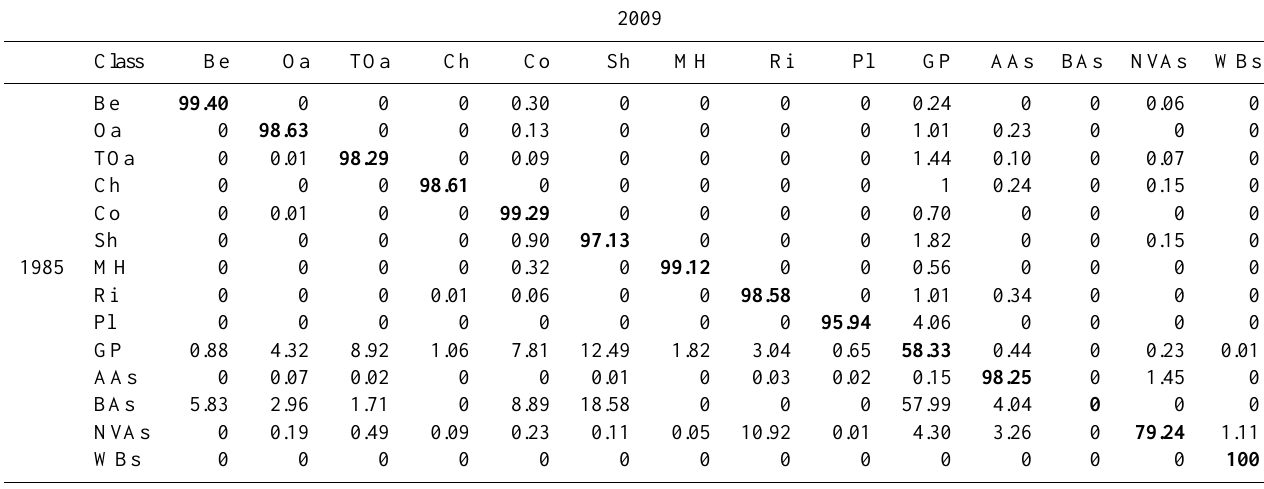
Table 3. Transition matrix. Percentages values are computed on the area occupied by each class in 1985. Bold in the main diagonal represents the proportion of stable lands in the analyzed period (1985–2009). (Abbreviations are shown in Table 2).